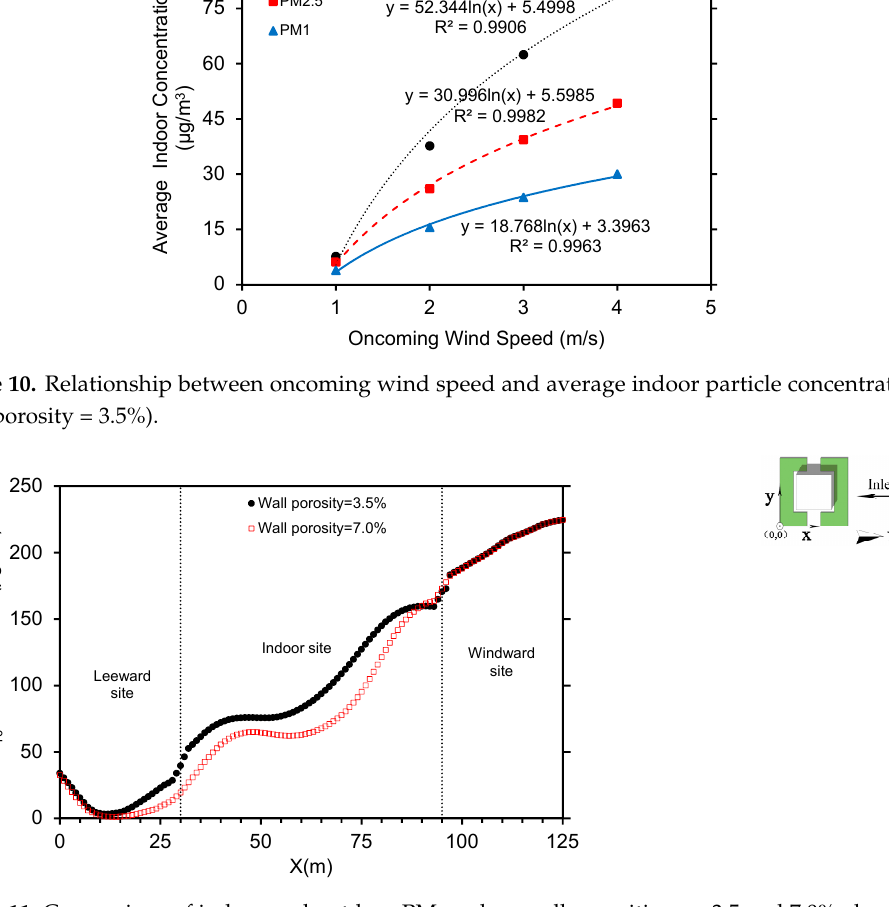
Figure 11. Comparison of indoor and outdoor PM 10 when wall porosities are 3.5 and 7.0% along the horizontal plane at y = 53 m and z = 1.5 m.